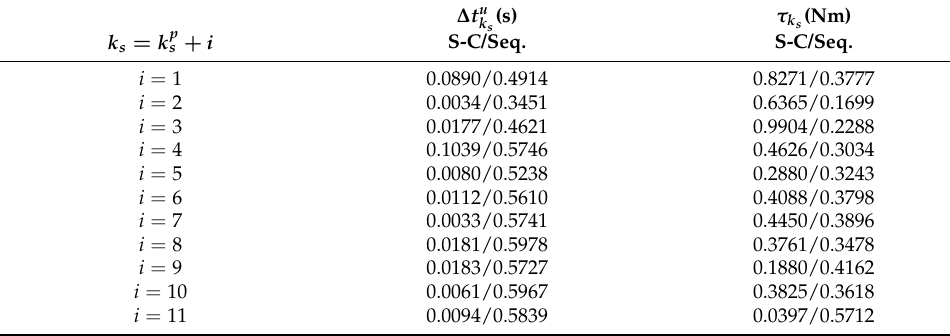
Table 6. Optimal semi-passive control design variables associated with the best solutions obtained by structure-control (S-C) and sequential (Seq.) design